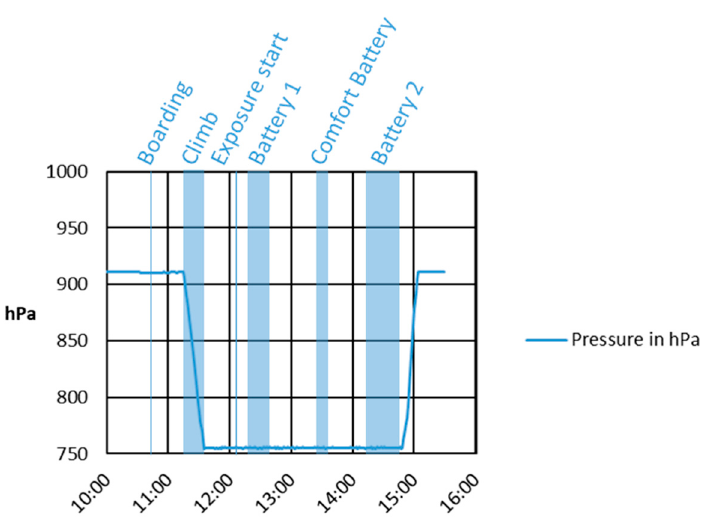
Figure 4. Example of Cabin pressure profile